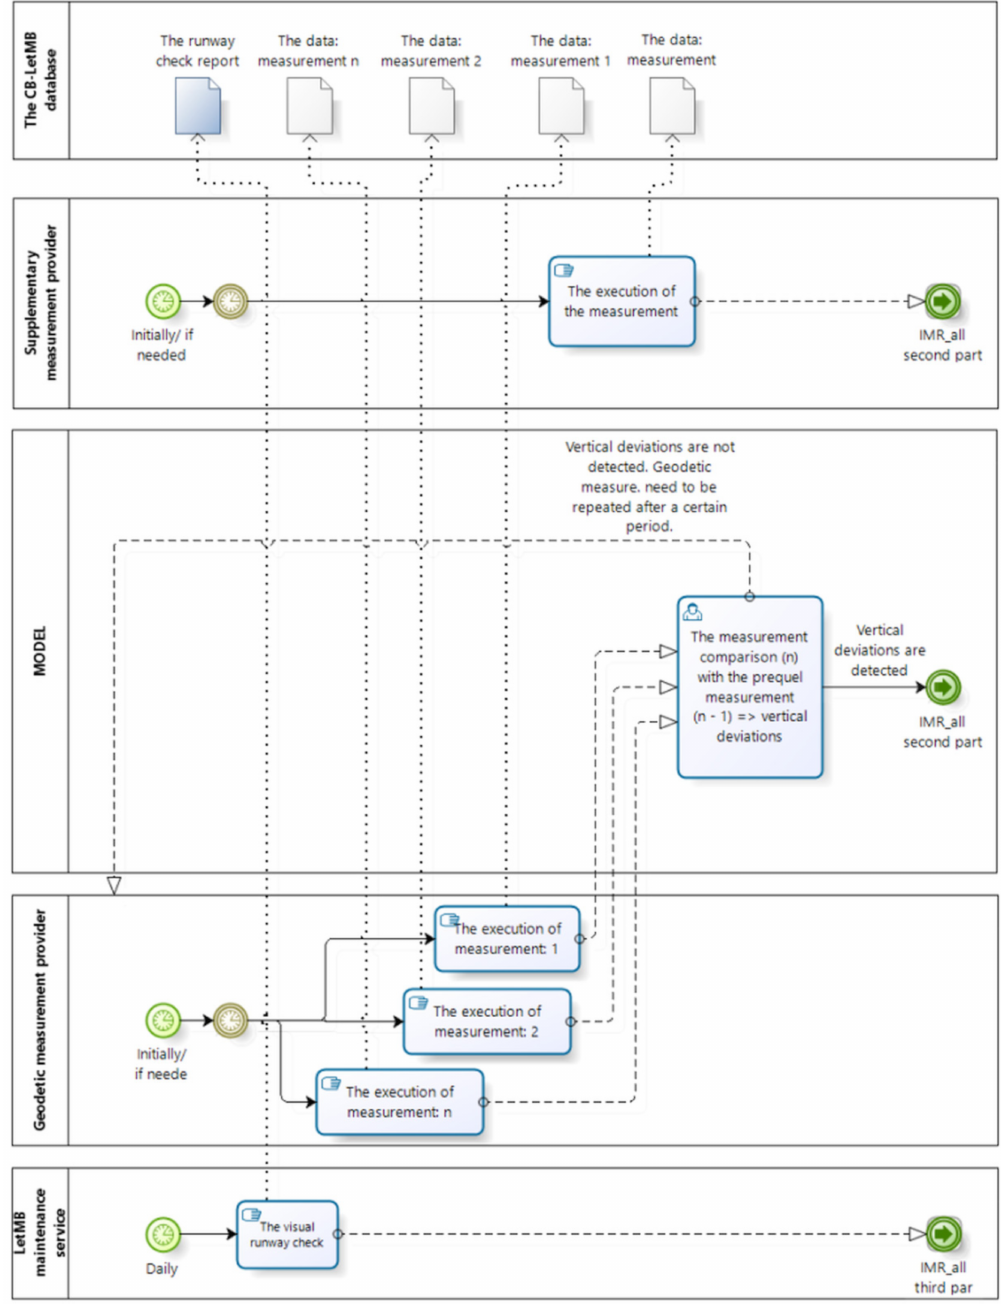
Figure 8. First part of BPD’s process decision-making maintenance model